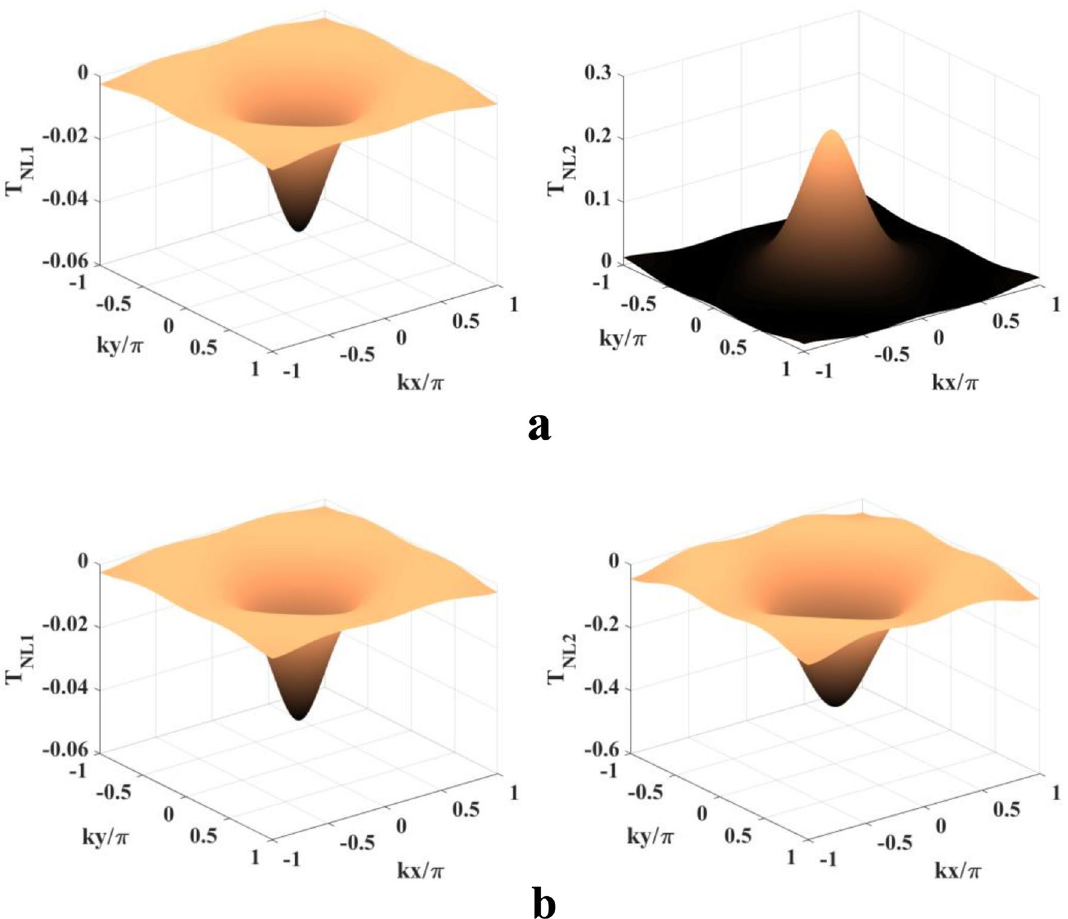
Figure 7. Contribution of the nonlinear terms ( T NL 1 and T NL 2 ) to probe absorption-gain spectra of Fig. 6: ( a ) Parameters are same as those for the right panel of Fig. 6a. ( b ) Parameters are same as those for the right panel of Fig.